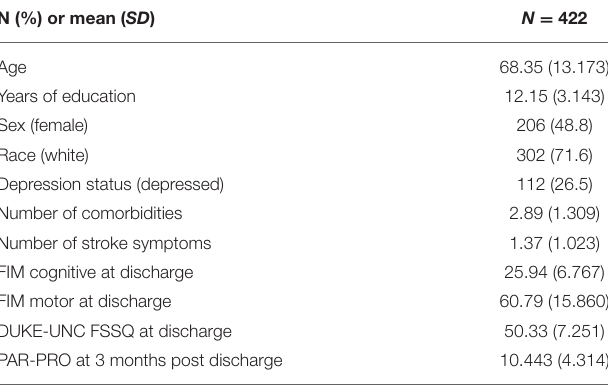
TABLE 1 | Demographics and